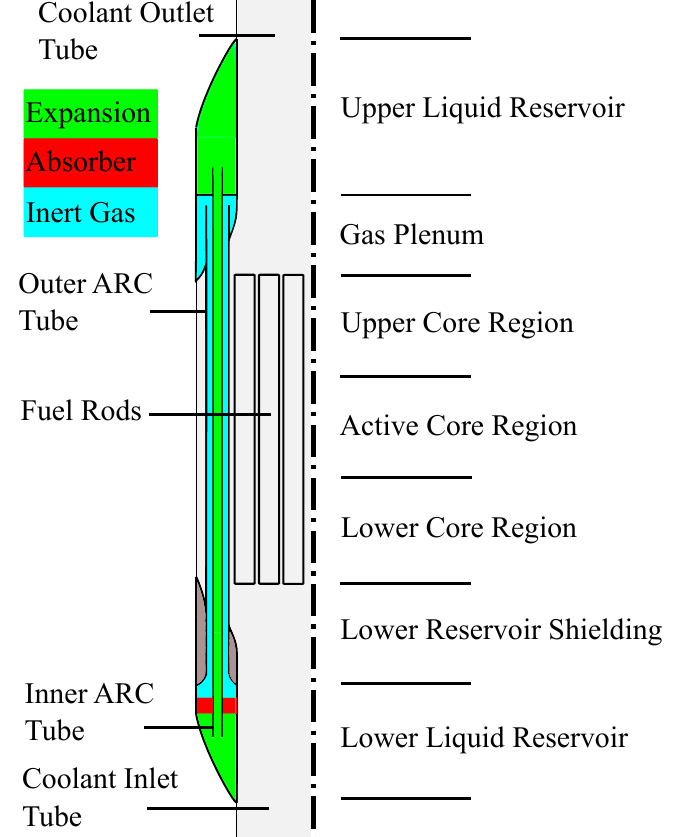
Figure 1: Main components of the ARC system installed on a fuel